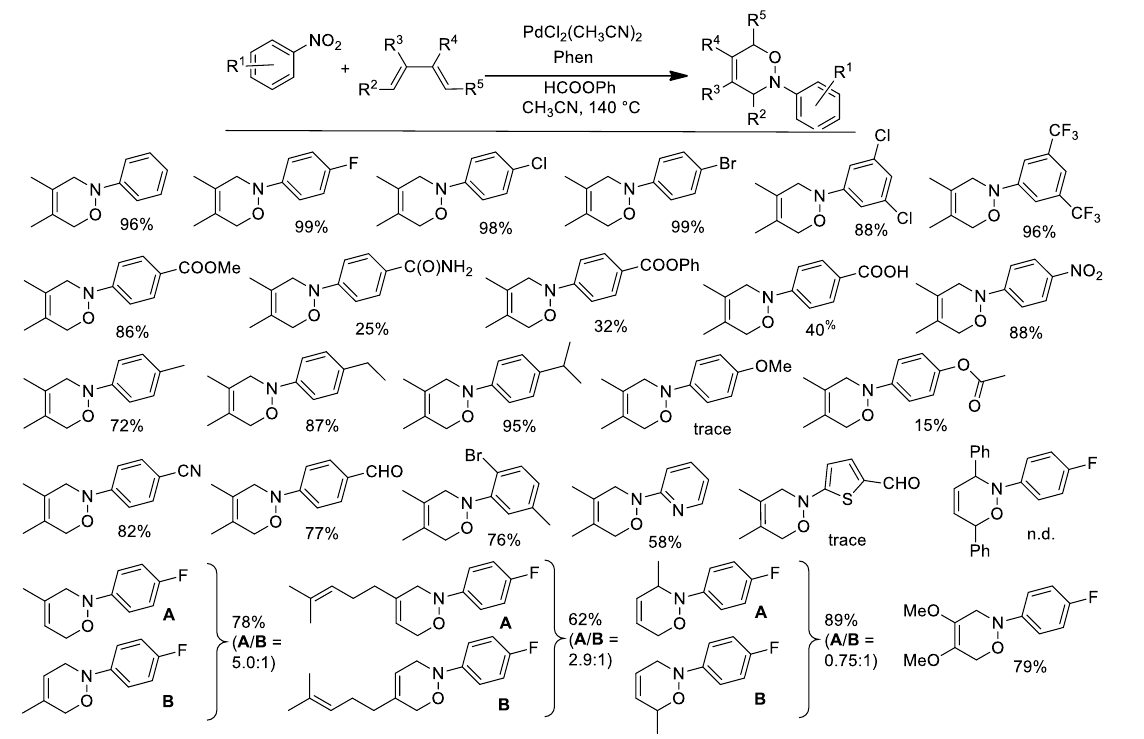
Figure 3. Synthesis of oxazines from nitroarenes and conjugated dienes. Experimental conditions: nitroarene 0.54 mmol, Pd(CH 3 CN) 2 Cl 2 1 mol %, Phen 2.5 mol %, diene 4 equiv, HCOOPh 2.2 mmol, Et 3 N 0.27 mmol, in CH 3 CN (10 mL) at 140 °C.